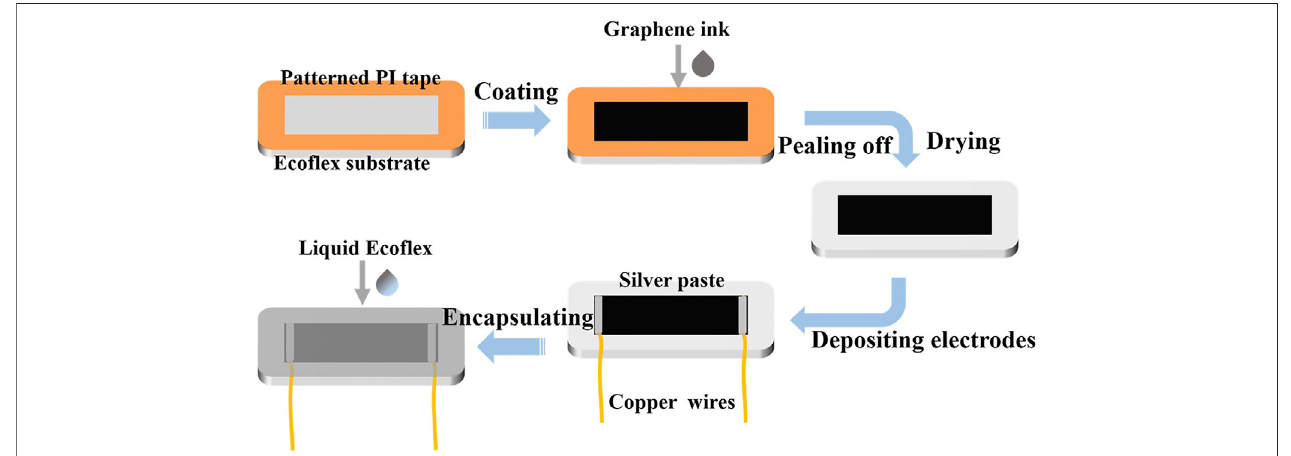
FIGURE 1 | Schematic illustration for the preparation of the fl exible graphene strain sensor.